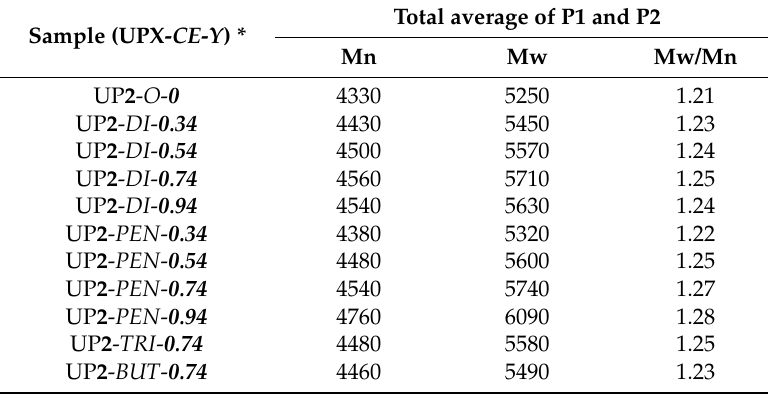
Table 6. The integrated molecular weight and distribution for P1 and